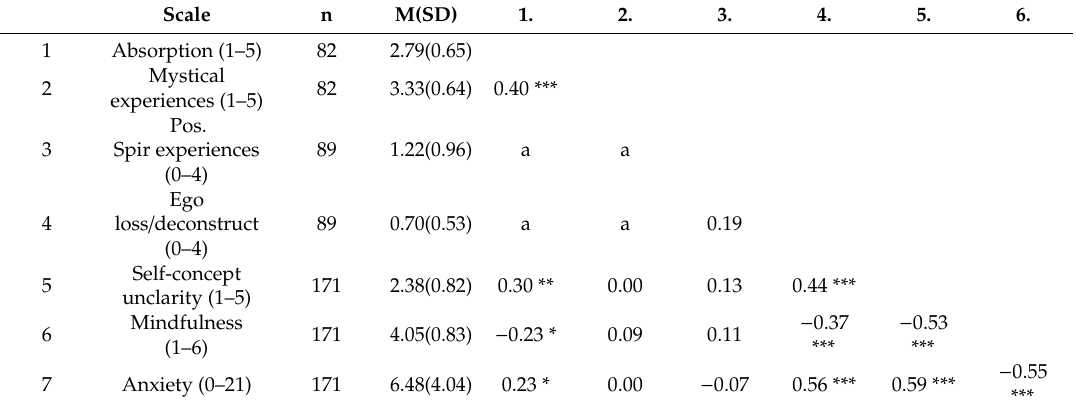
Table 1. Means, Standard deviations, intercorrelations regarding “Loss of Self” measures and Anxiety. Scale n M(SD)